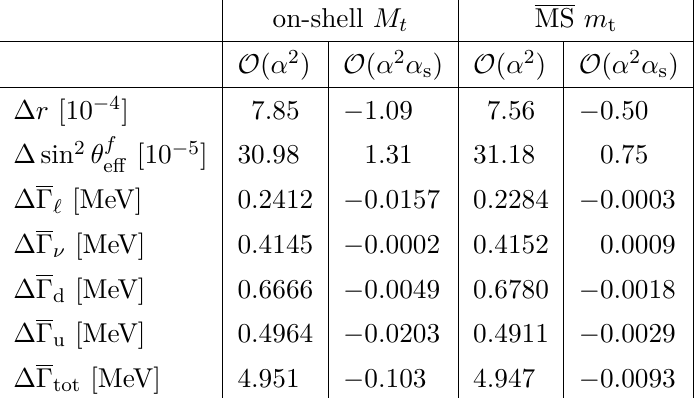
Table 5 . Numerical comparison of leading fermionic O ( α 2 ) and O ( α 2 α s ) results between the on- shell and MS top-quark mass prescriptions. See text for more